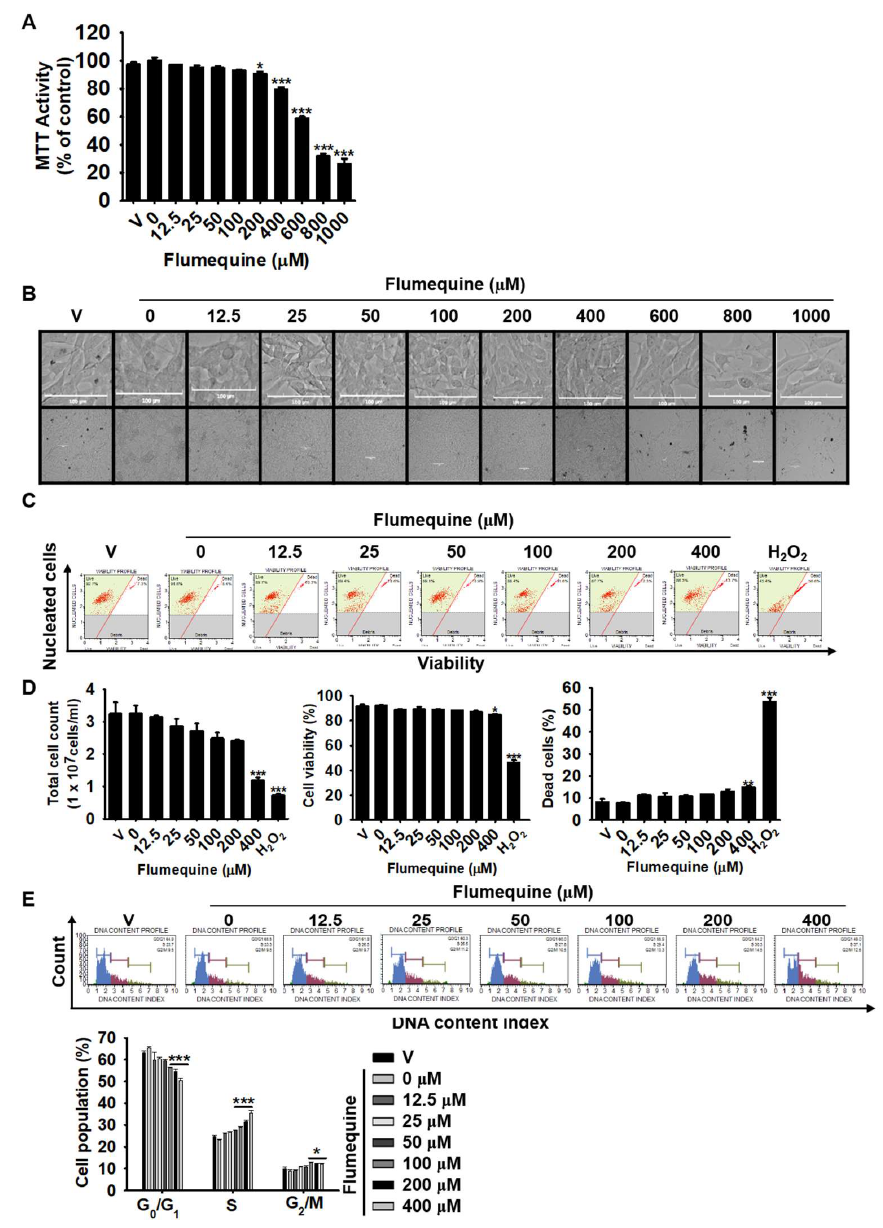
Figure 2. High concentrations of flumequine slightly decrease the viability of B16F10 cells. B16F10 cells were treated with 0–1000 μM flumequine for 72 h. ( A ) A 3-(4,5-dimethylthiazol-2-yl)-2,5-diphenyltetrazolium bromide (MTT) assay was performed to determine cell viability. Cell viability in each group was presented as the percentage of the values of the untreated control. ( B ) The cellular images were captured and analyzed. ( C and D ) B16F10 cells were treated with 0–400 μM flumequine for 72 h. Flow cytometric analysis was used to assess total cell count (left), cell viability (middle), and apoptotic cell population (right). ( E ) Cell cycle analysis carried out using the Muse™ cell cycle kit after treating with 0–400 μM flumequine for 72 h (top) and cell cycle distribution is represented (bottom). The results are the average of the three independent experiments; the data are expressed as the mean ± SEM: *** , p < 0.001, ** , p < 0.01, and *, p < 0.05 vs. untreated control. V, vehicle control (0.1% DMSO). 3.3. Flumequine Increases Extracellular and Intracellular Melanin Production in B16F10 Cells